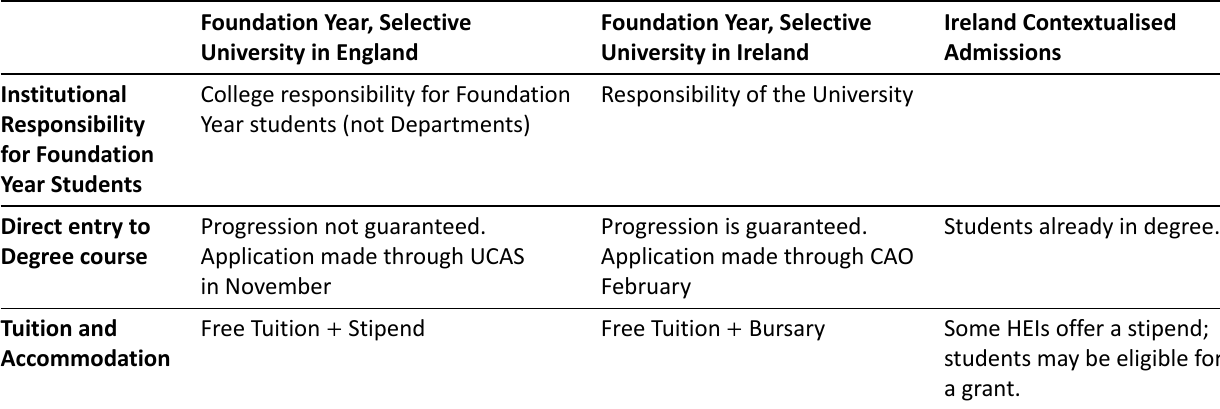
Table 1. (Cont.) Key characteristics contextualised admission in Ireland and foundation years in two selective universities in Ireland and